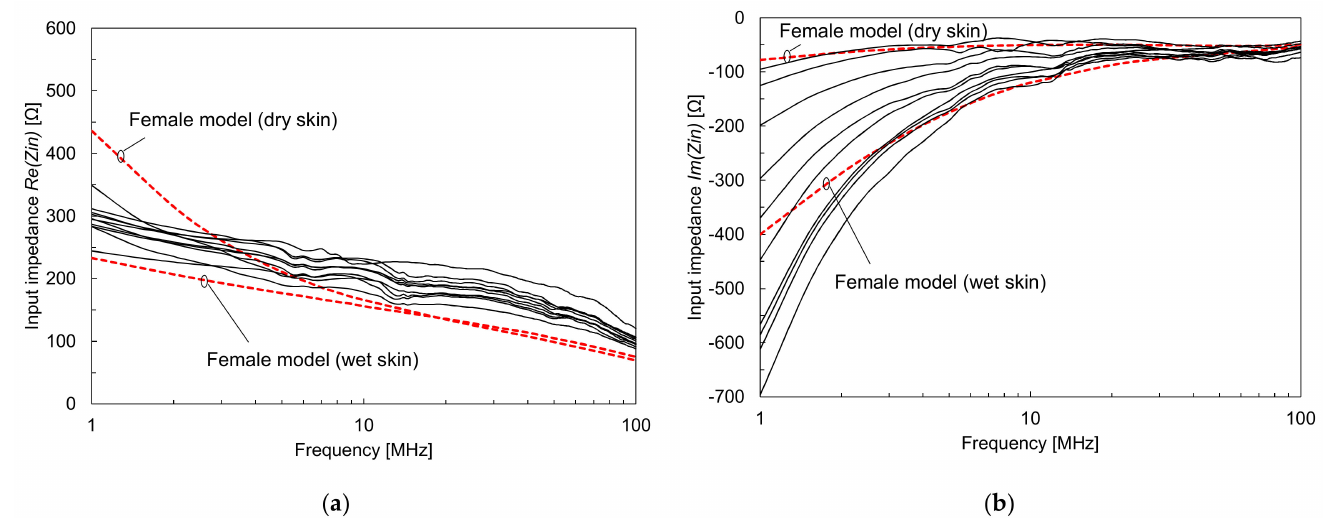
Figure 8. Input impedance characteristics of the wearable antenna measured by using female subjects: ( a ) Real component of input impedance characteristics; ( b ) imaginary component of input impedance